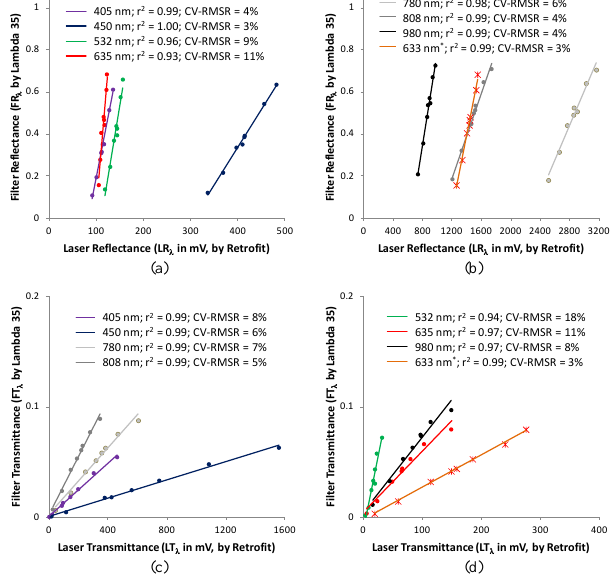
Figure 3. Comparison of organic and elemental carbon by re- flectance optical correction (i.e., OCR and ECR, respectively) be- tween the conventional thermal/optical analysis (TOA based on 633nm optical split) and seven-wavelength thermal/spectral analy- sis (TSA based on 635nm optical split) following the IMPROVE_A protocol. Note that x and y axes are on log scales. lengths that have the lowest LR or LT uncertainties. ECRs 808 nm split (i.e., slopes within the standard error from